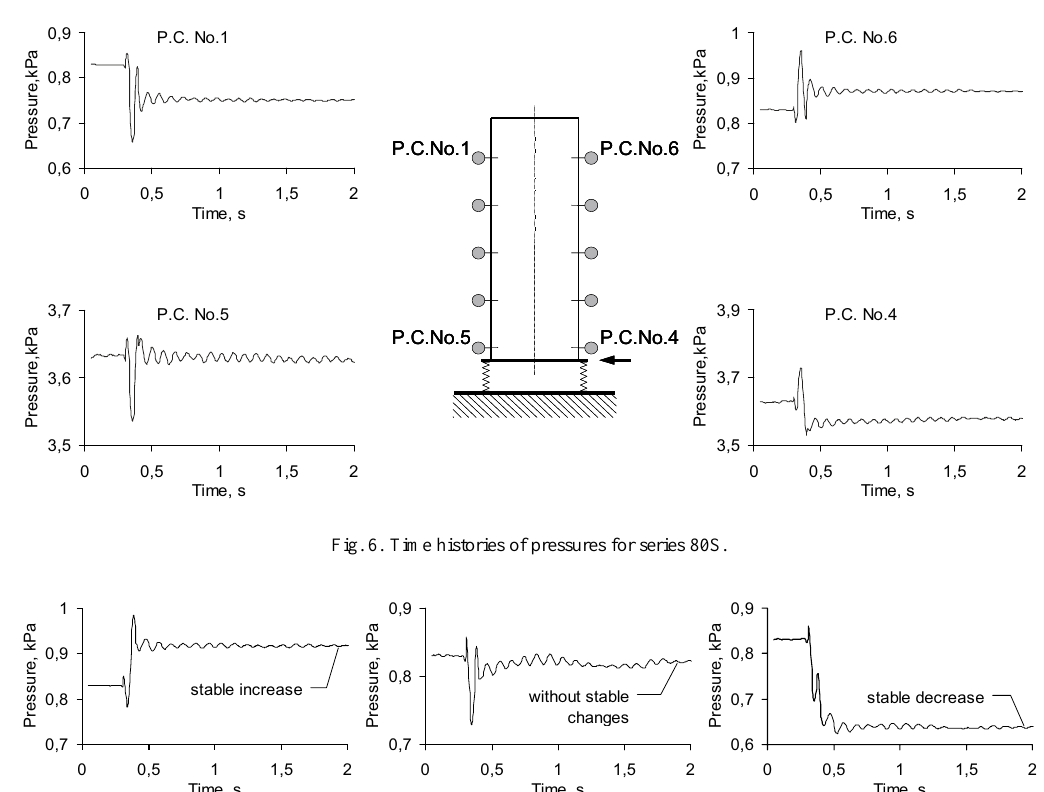
Fig. 7. Nature of stable changes of pressures (series 60P, P.C.